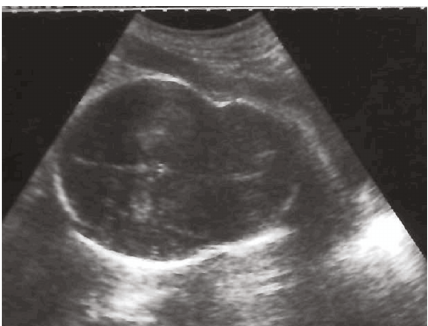
Figure 1: Abnormal skull shape observed by conventional sono- graphic